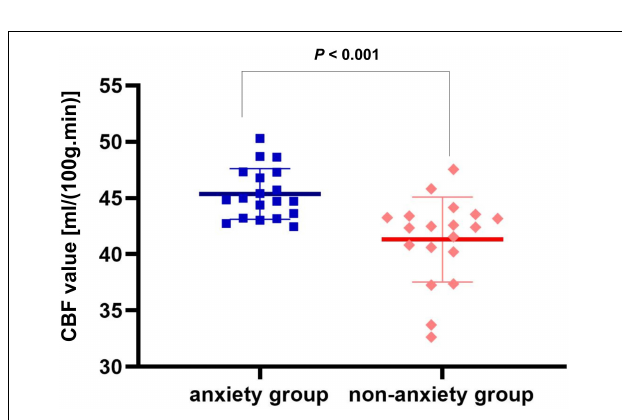
FIGURE 2 | Two-sample t test of CBF in the right insula/Heschl’s cortex between anxiety group and non-anxiety group.